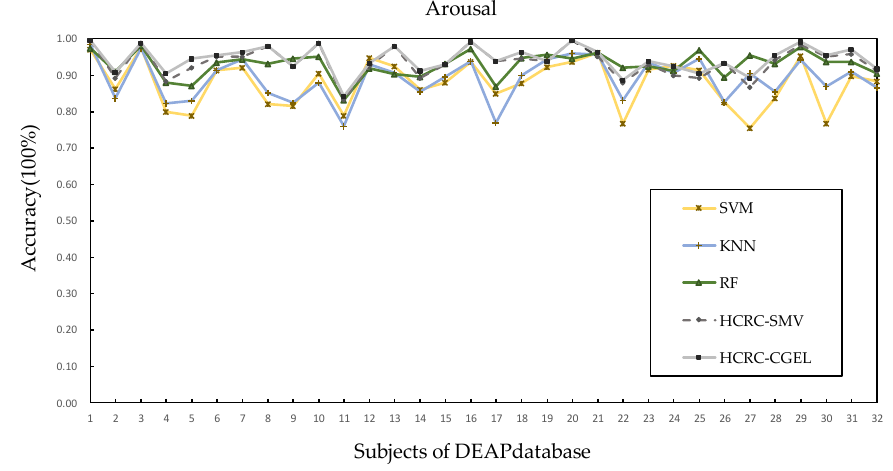
Figure 5. Results of each method for arousal on DEAP database.